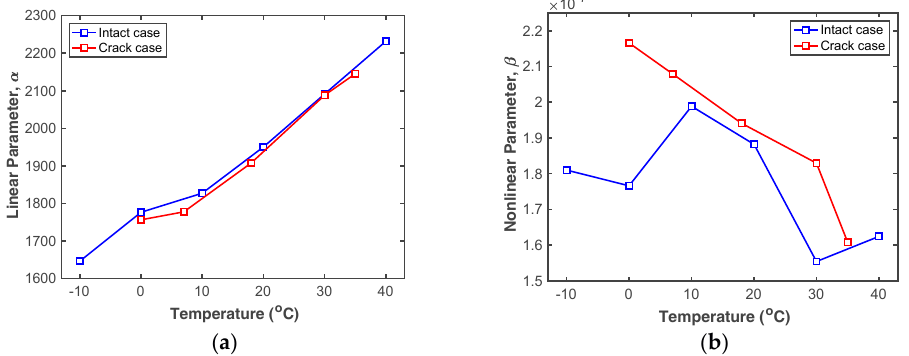
Figure 11. Comparison of ( a ) α and ( b ) β obtained from the intact and cracked specimens under changing temperature.